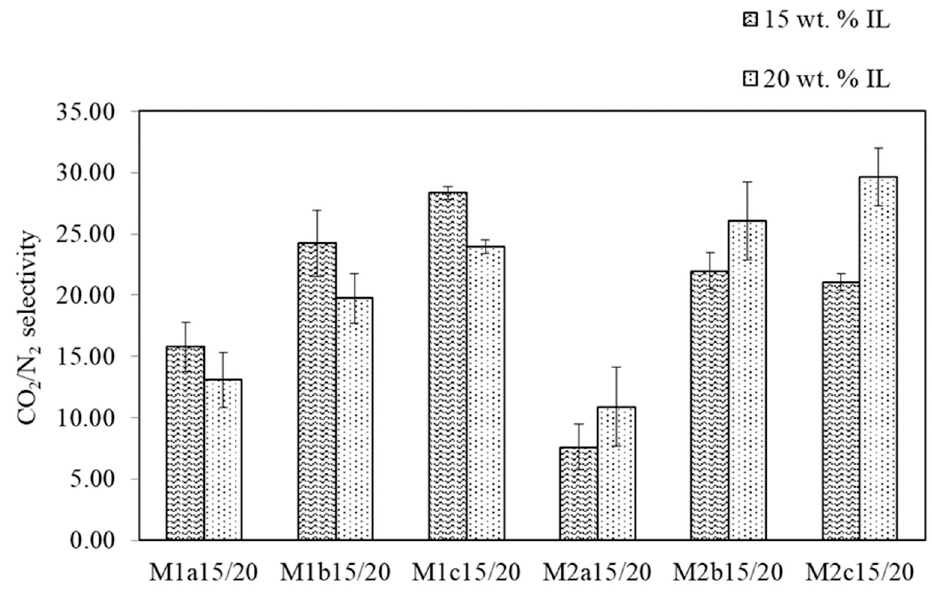
Figure 9. CO 2 single gas selectivities of M1/2a15/20–M1/2c15/20 ( ϑ = 28 °C, ∆ p = 2 bar).